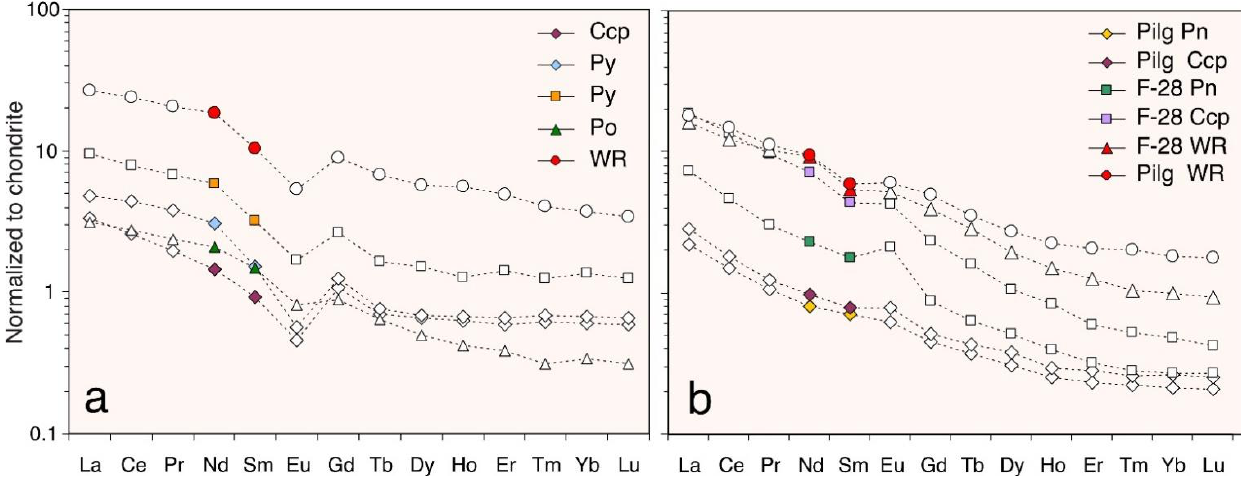
Figure 2. REE distribution in rock (WR) and sulfide minerals from magmatic Cu-Ni-PGE complexes of the Fennoscandian Shield: ( a ) Penikat intrusion, Finland; ( b ) Pilgujärvi Cu-Ni deposit (Pilg) and Ahmavaara intrusion (F-28). Pn — pentlandite; Ccp — chalcopyrite; Pn — pentlandite; Po — pyrrhotine; WR — whole rock.